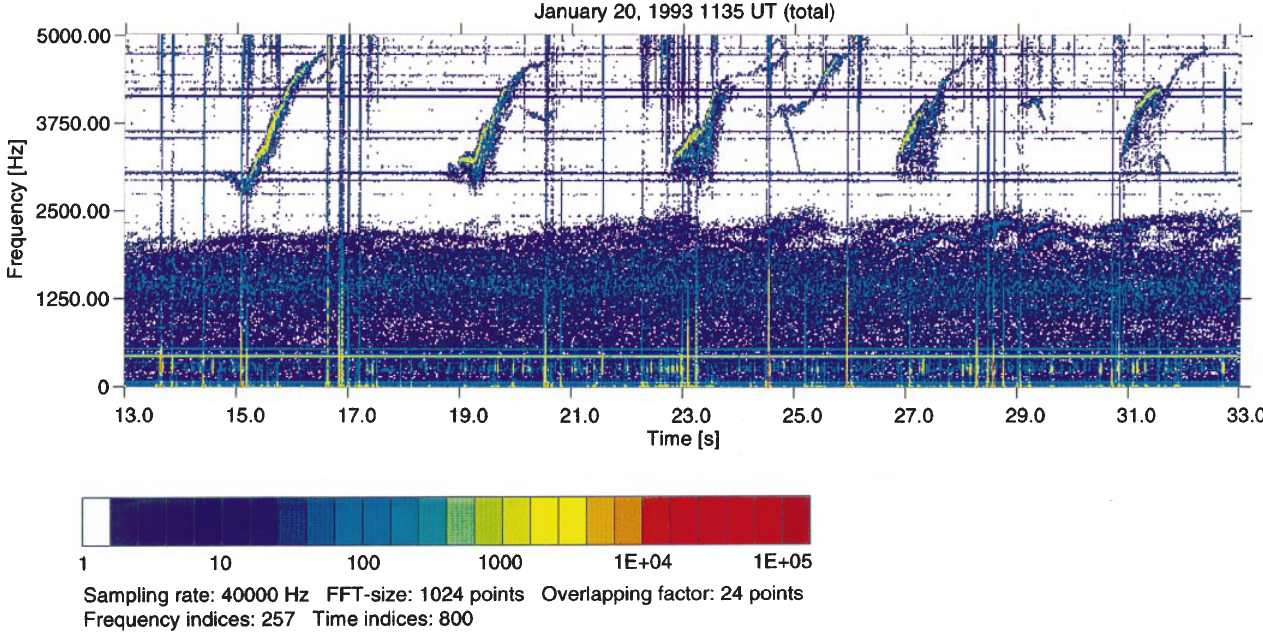
Fig. 1. Strong rising frequency emissions triggered by a pair of prominent lines at 2950/3050 Hz. The periodicity is the 2 hop wave period, and the broadening of each emission is due to the 2 hop echo of the previous